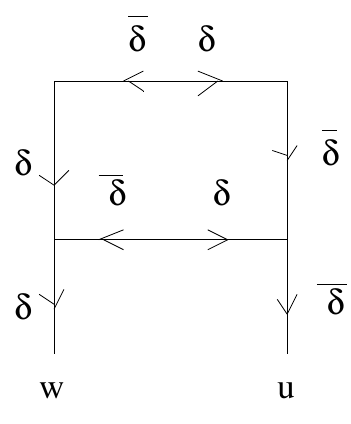
Figure 25 . Skeleton graph for (cid:8) 23 ;D (cid:0) 2(cid:8) 12 ;D